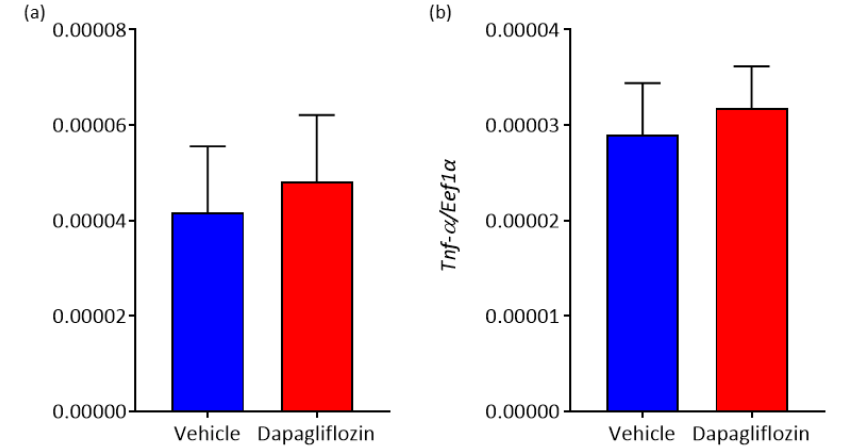
Figure 6. The e ff ect of SGLT2 inhibition on pro-inflammatory cytokine expression in WAT. ( a ) Interleukin Figure 6. The effect of SGLT2 inhibition on pro-inflammatory cytokine expression in WAT. ( a ) ( Il-6 ) mRNA expression and ( b ) Tnf- α mRNA expression; n = 7–8 mice / group. All data are presented as Interleukin ( Il-6) mRNA expression and ( b ) Tnf- α mRNA expression; n = 7–8 mice/group. All data are mean ± presented as mean ± SEM.